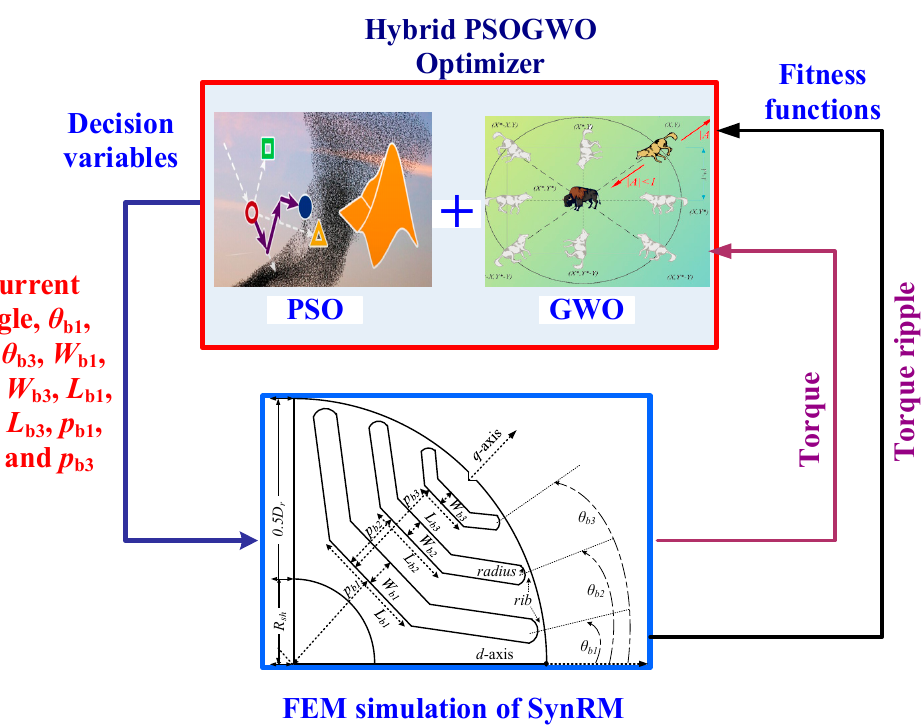
Figure 2. Flow chart of the optimization process.